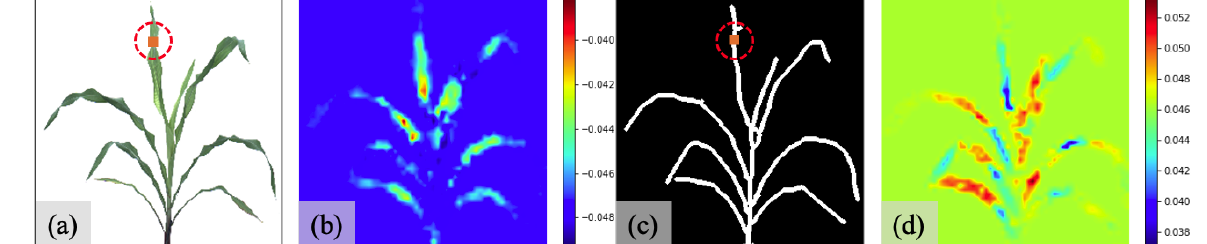
Figure 5. Heatmaps from input modification method for datasets S1: ( a ) original sorghum image with a sliding window of size ( 10 × 10 ) (within the red dash circle); ( b ) heatmap derived from Figure 5a; ( c ) skeleton image of Figure 5a with a sliding window of size ( 10 × 10 ) (within the red dash circle); ( d ) heatmap derived from Figure